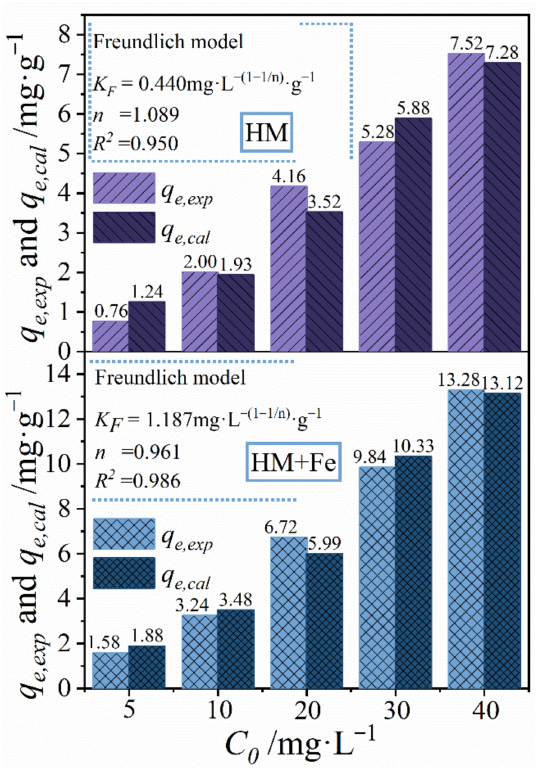
Figure 4. Parameters of adsorption isotherm model before and after HM aging.